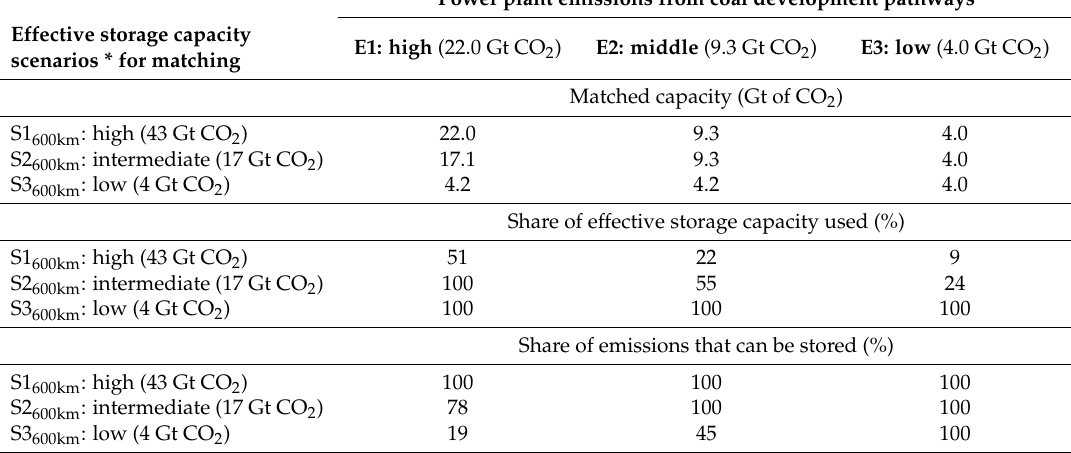
Table 6. Matched capacities for South Africa and their share in total storage capacity and supply in the base case (CCS from